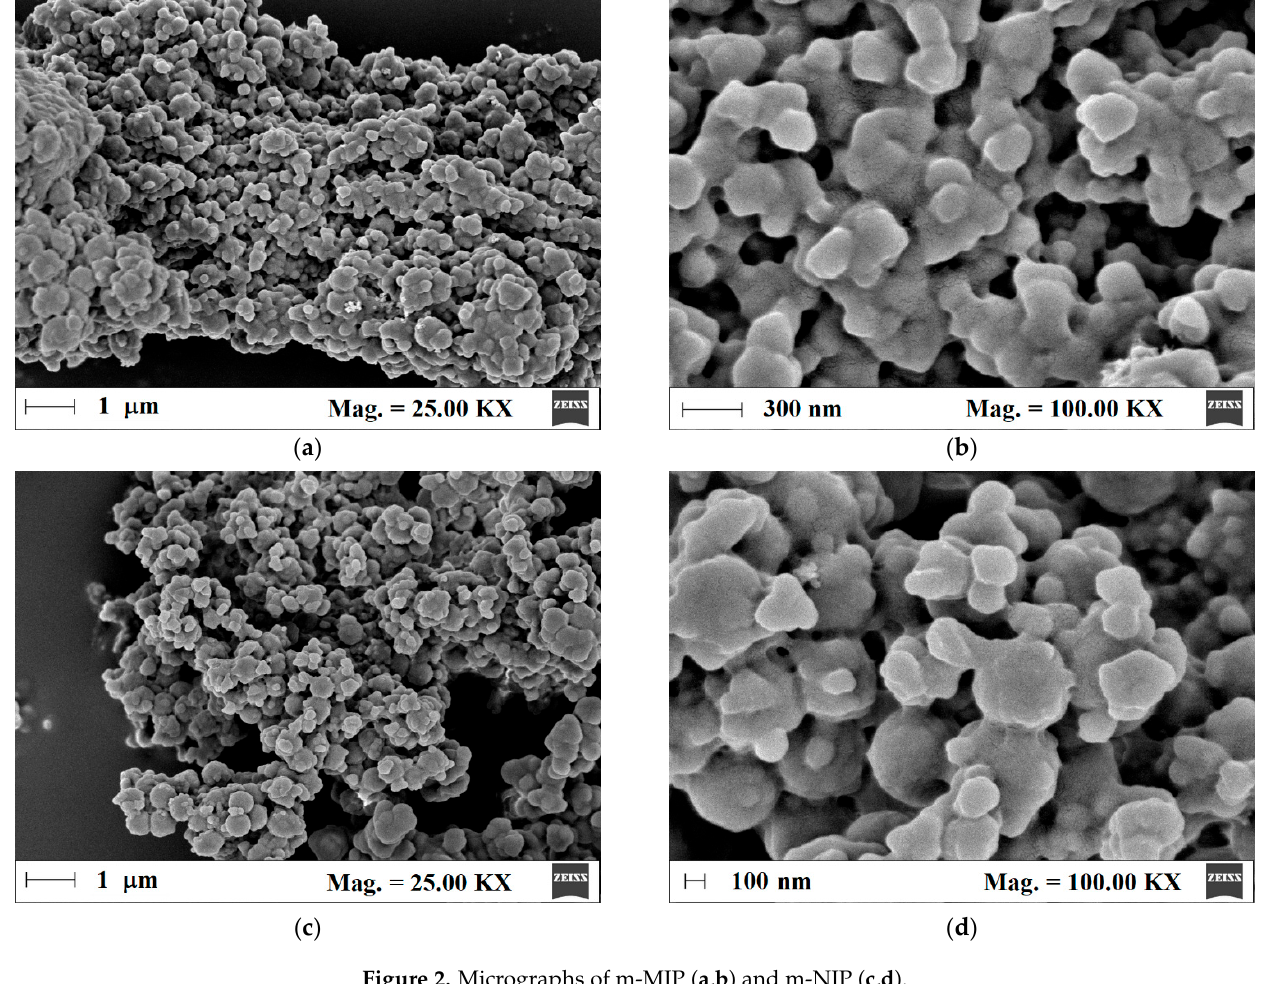
Figure 2. Micrographs of m-MIP ( a , b ) and m-NIP ( c , d ).